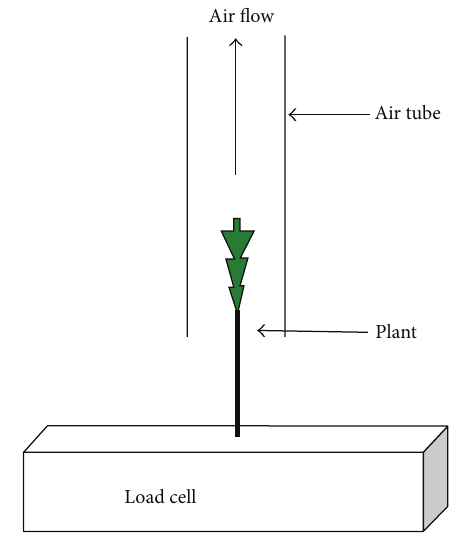
Figure 3: Schematic diagram illustrating the apparatus for measure- ment of flower terminal velocity.